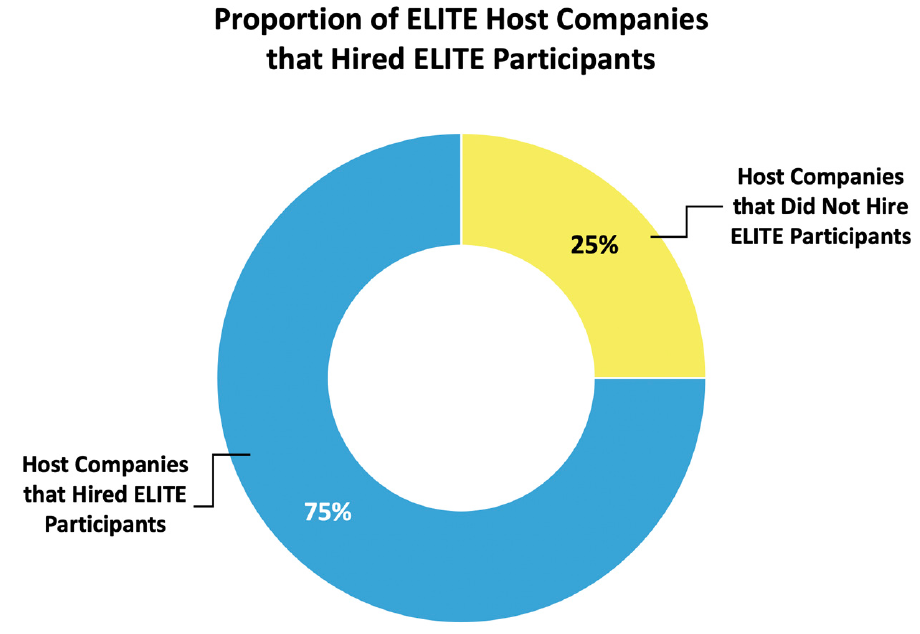
Figure 6. ELITE host company hiring percentages. A large majority (75%) of ELITE host companies have hired individuals who participated in the ELITE